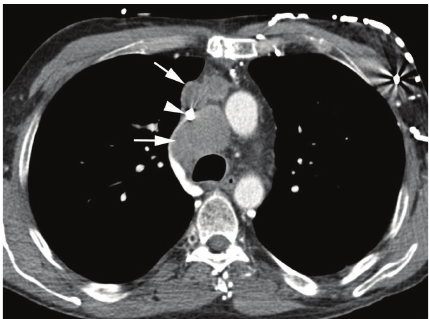
Figure1:AxialIVcontrast-enhancedCTimageshowsmarkedright paratracheal and anterior mediastinal lymphadenopathy (arrow) with marked compression of the superior vena cava (arrowhead).